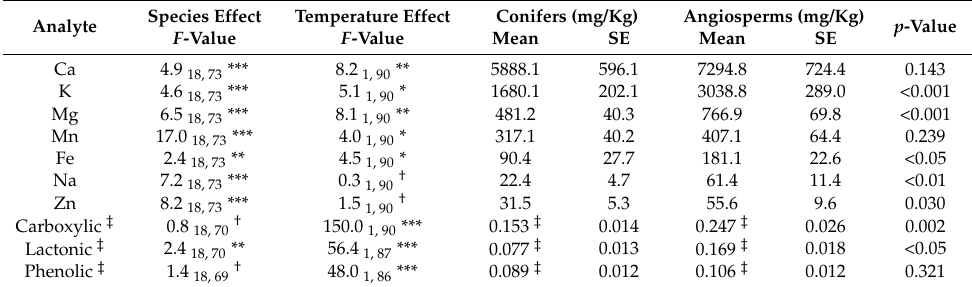
Table 1. Species and temperature effect on the variation of nutrient and surface group concentration between conifer and angiosperm species. The values shown are from 19 temperate tree species’ biochars ( n = 95) produced at pyrolysis temperatures of 300, 400, 500, 600, and 700 ◦ C.